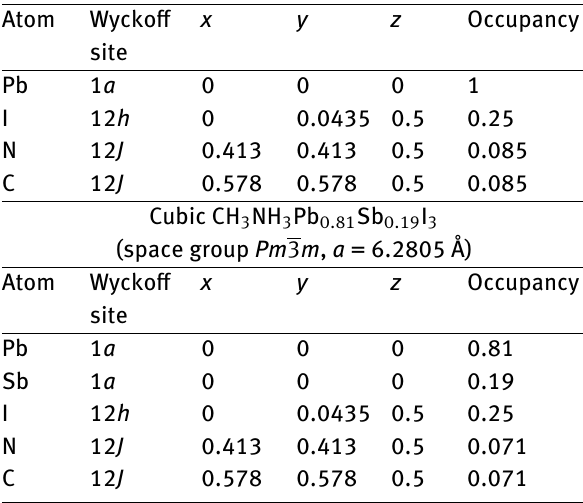
Table 15: Optimized crystal structures and occupancy